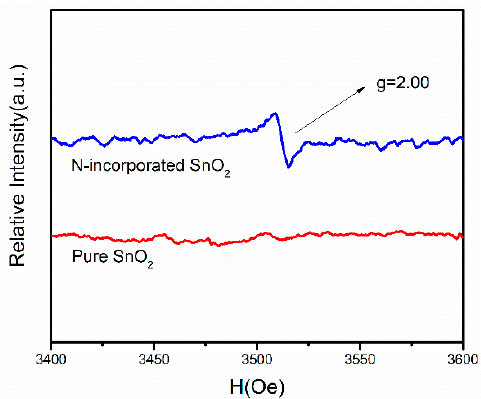
Figure 7. Electron paramagnetic resonance (EPR) signals of N-incorporated SnO 2 and pure SnO 2